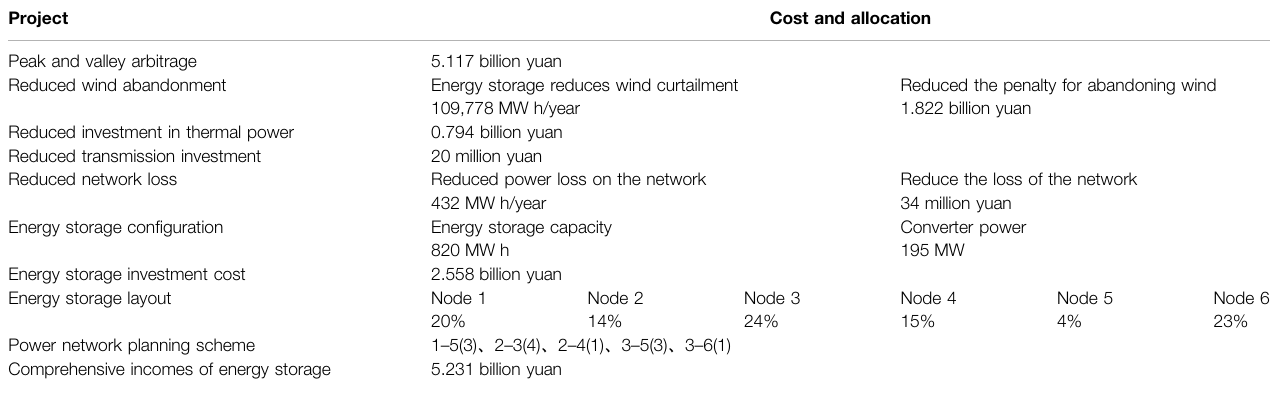
TABLE 4 | Source-storage-transmission planning under the time trisection